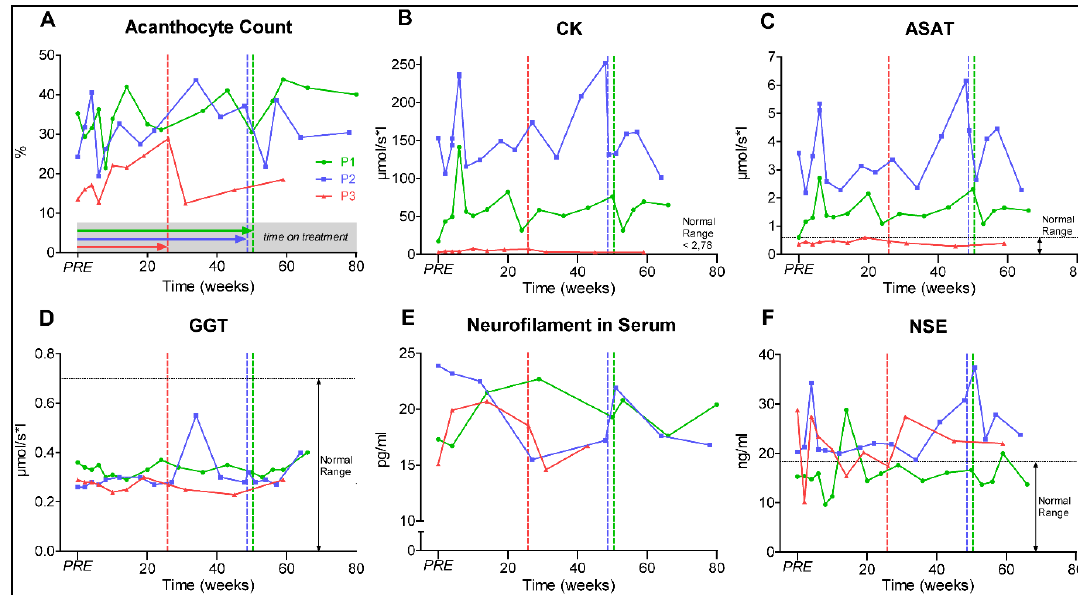
Figure 3. Graphs ( A – F ) represent ChAc biomarkers. Patients 1–3 (P1–3), PRE represents baseline value before initiation of dasatinib treatment, dotted vertical lines represent individual end of treatment. Alanine aminotransferase (ALAT); Gamma-glutamyltransferase (GGT).